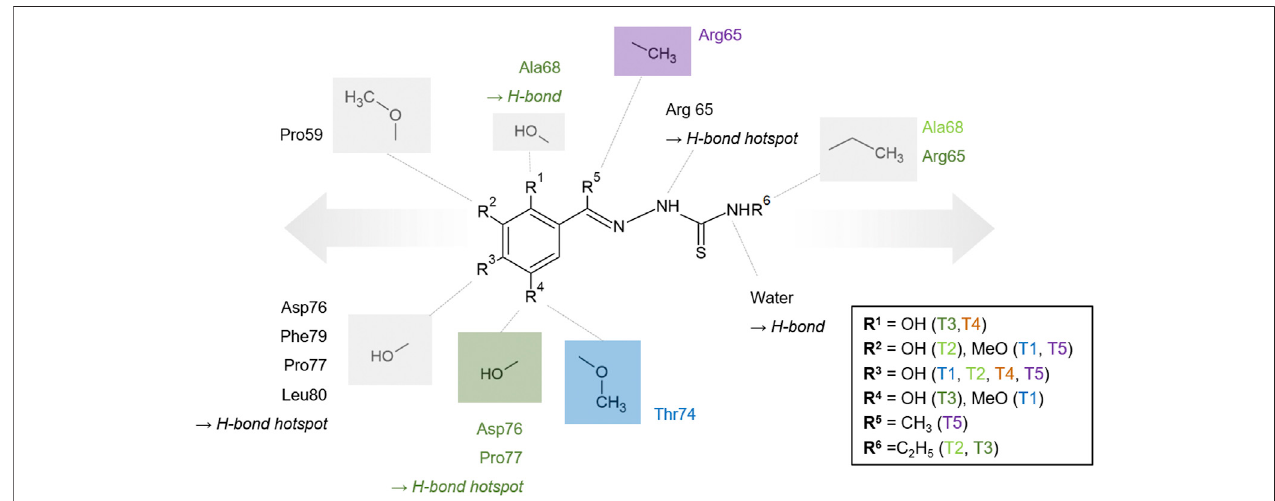
FIGURE 7 | Generic and schematic binding model of the thiosemicarbazones core structure based on the investigated derivatives. Selected PLpro amino acids participating in hydrophobic interaction and hydrogen bonds are displayed and additionally color-coded if they are only relevant for one of the compounds. Conserved and individual hydrogen bond positions are labeled. Moieties, which are exclusively presentinone compound, are color-coded, e.g., themethoxylationin thepositionof R 4 isexclusivefor T1and colored blue accordingly. The proposed options toextend the thiosemicarbazone compounds,either at the phenylring or at theterminal nitrogen of the thiourea moiety, are indicated schematically by